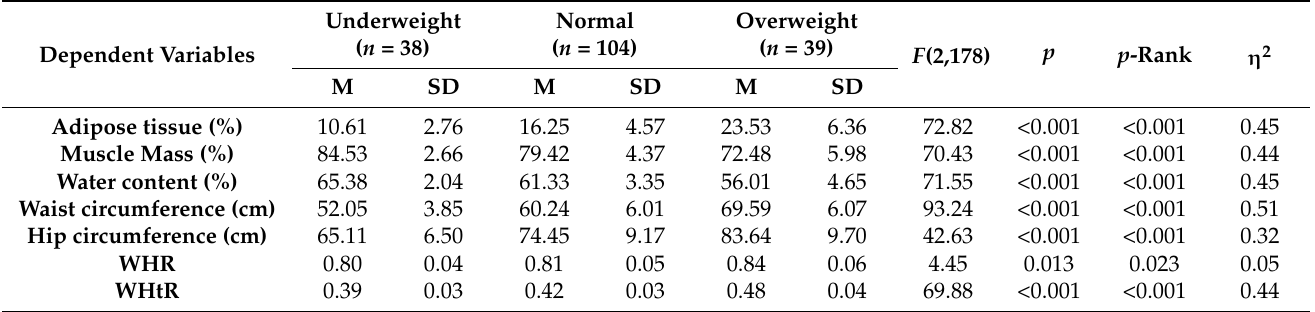
Table 4. Analysis of differences using one-way analysis of variance comparing body composition components among individuals with different BMI levels.